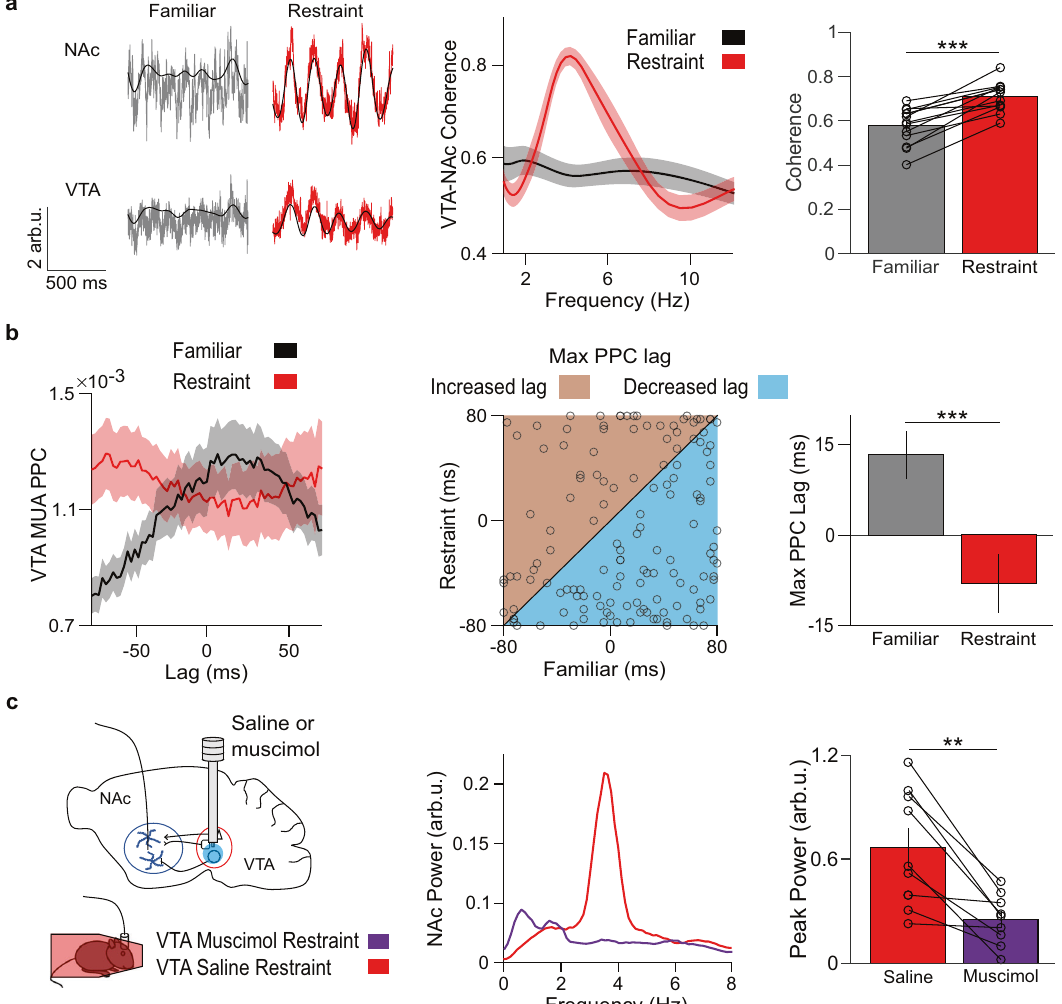
Fig. 3 VTA neural activity leads NAc activity during restraint. a Left: example traces of NAc and VTA LFPs during familiar environment exploration (gray) or restraint (red), overlaid with the 4 Hz fi ltered signal (black). Center: coherence of VTA and NAc LFPs. Right: restraint increases average VTA-NAc coherence in the 4 Hz range (*** P = 0.00024 two-tailed paired t test, n = 13 mice). Data are mean ± s.e.m. b Left: PPC between VTA MUA and the 4 Hz fi ltered NAc LFP at different MUA time lags. Restraint increased synchrony of NAc 4 Hz phase with past VTA MUA. Center: relationship between lag of max VTA MUA-NAc PPC during familiar environment exploration and restraint, with the line of equality for reference. Right: summary of data from the center panel. Restraint reorganized VTA MUA from predominantly lagging NAc phase to predominantly leading NAc phase (*** P = 0.00033 two-tailed signed-rank test, n = 138 multi-units). Data are mean ± s.e.m. C Left: experimental design. Center: example NAc LFP power spectra following VTA infusion of saline (red) or muscimol (violet). Right: Muscimol reduced maximum 4 Hz NAc power during restraint (** P = 0.0020 two-tailed signed-rank test, n = 9 mice). Data are mean ±